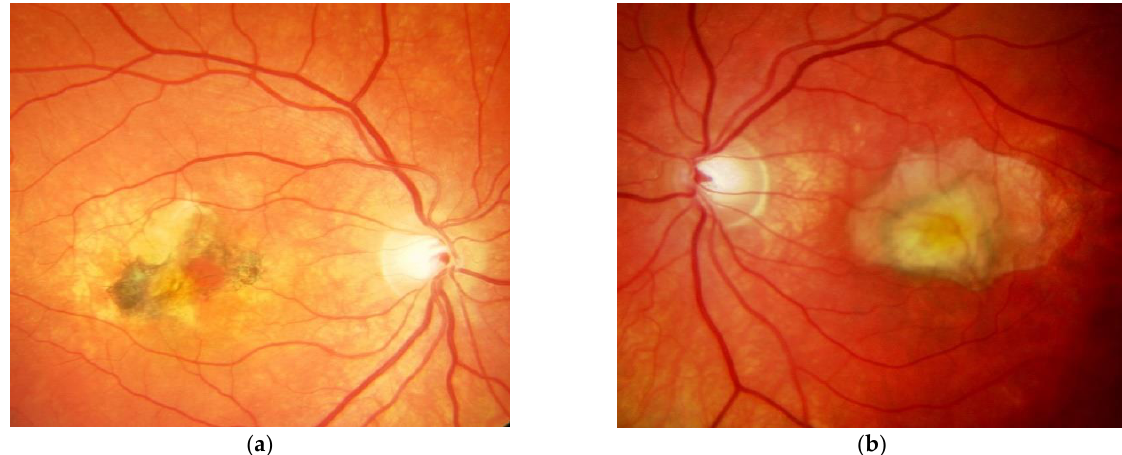
Figure 2. Same patient, 5 years later. First reactivation of macular neovascularisation evidenced by vision loss and a small macular hemorrhage as well as newly present intraretinal fluid in OCT in the right eye ( a ) and macular pigment atrophy in both eyes ( a , b ).